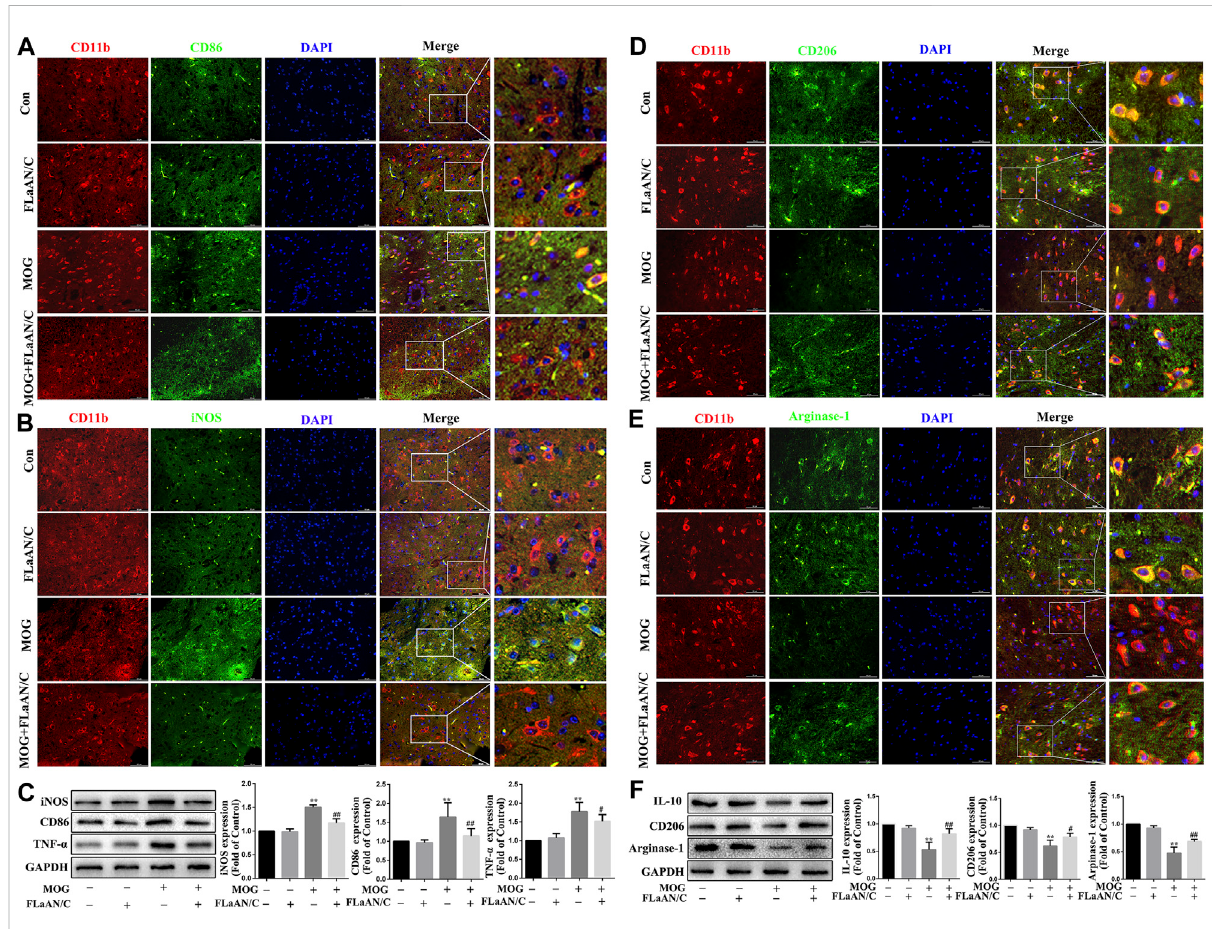
FIGURE 2 FLaAN/CshiftedM1toM2phenotypeinspinal cordofmicewithEAE.Themicewereeuthanizedonpost-immunizationday30.Thespinalcord tissue of each group of mice were isolated and embedded in paraf fi n.Immuno fl uorescence was used to detect the colocalization of CD11b with M1 markers (iNOS and CD86) and M2 markers (Arginase-1 and CD206) in spinal cord tissue.The representative images show the expression levels of CD86 + (A) , iNOS + (B) , CD206+ (D) and Arginase-1 + (E) in CD11b + cells (scale bars: 50 μ m). (C) The protein expression levels of iNOS, CD86 and TNF- α in the spinal cord of each group was detected by western bloting. (F) The protein expression levels of Arginase-1, CD206 and IL-10 in the spinalcordofeachgroupweredetectedbywesternbloting.Dataareshownasmeans±SD(n=6pergroup).* p < 0.05,** p < 0.01,*** p < 0.001; # p < 0.05, ## p < 0.01, ### p < 0.001. * vs. Control group; # vs. MOG